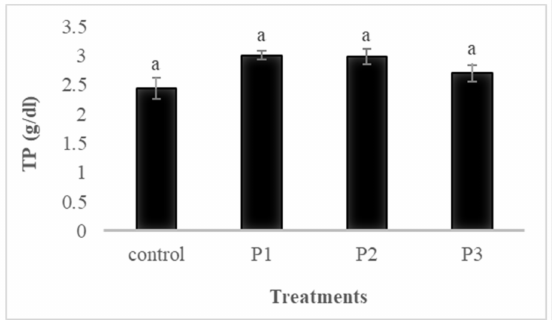
Figure 1. The effects of dietary pectin on serum total protein of rainbow trout fed four experimental diets with different inclusion levels control: 0, P1: 5, P2: 10, and P3: 20 g of apple pomace derived pectin (APDP) for 30 days. Bars assigned with same superscripts are not significantly different ( p > 0.05); values are presented as the mean ± SE. ( n = 9).